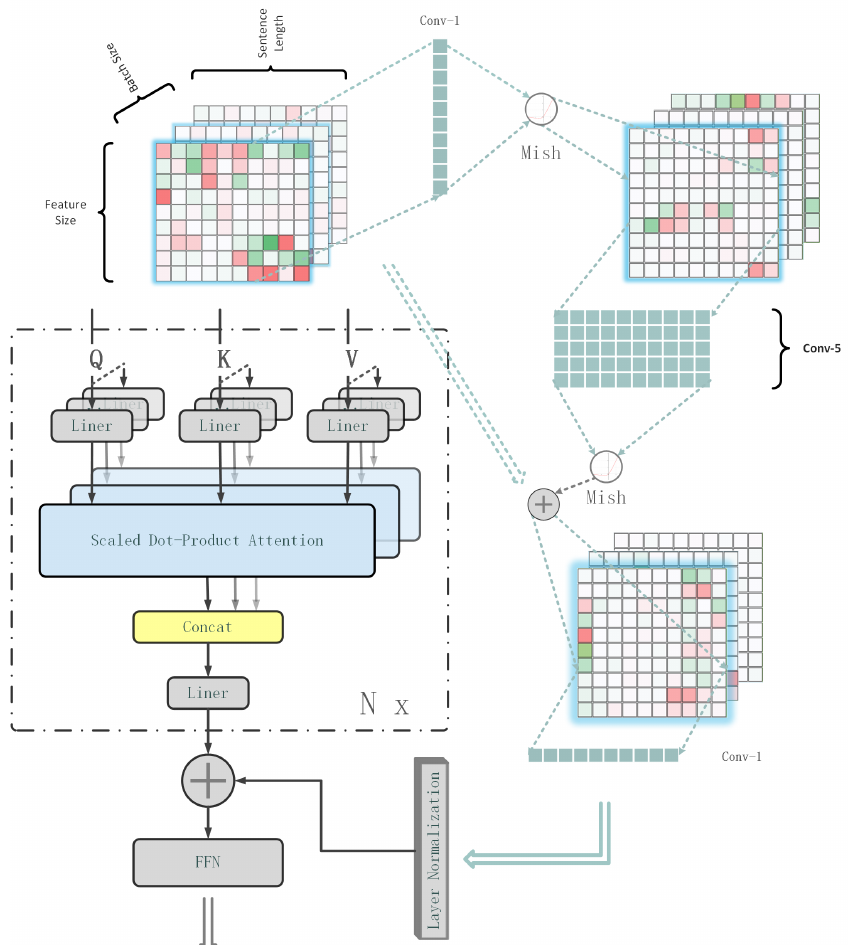
Figure 2. MASCOT encoder structure of our